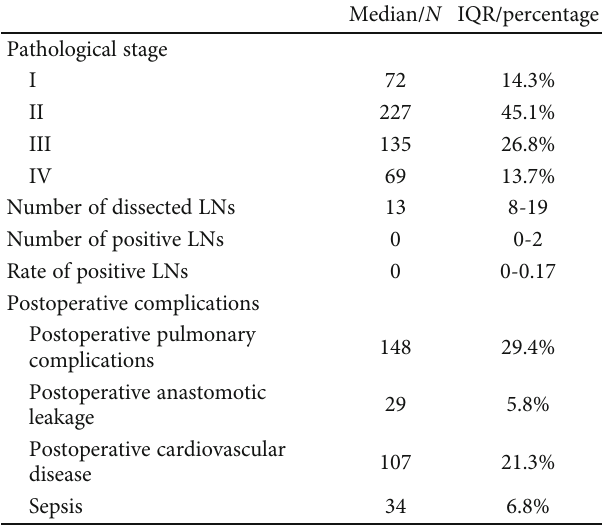
Table 1: Clinical, epidemiological, and pathological